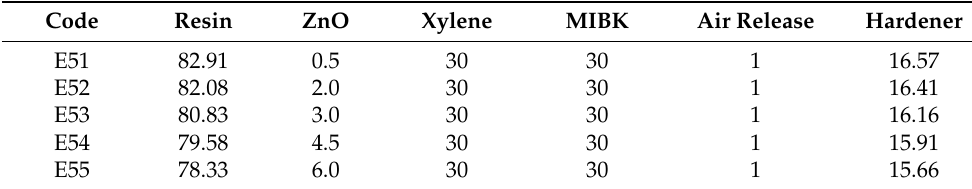
Table 1. Composition details of the prepared